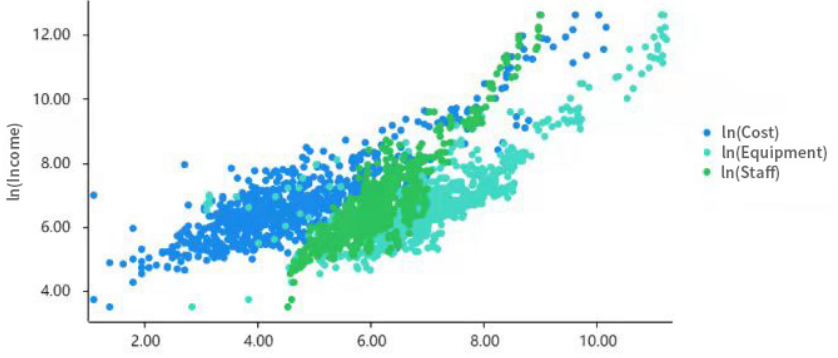
Figure 1. Fitted scatter plot of each input variable and Income.